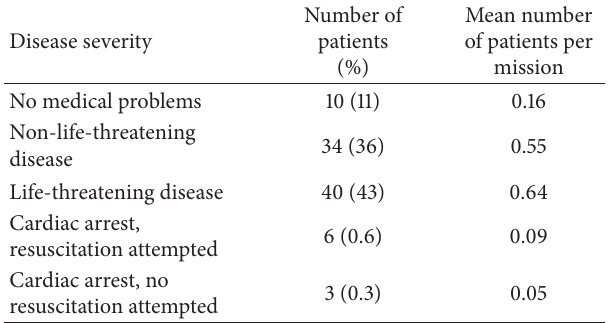
Table 3: Disease severity, by patient and by accomplished mission. Table 4: Reasons for theoretical benefits over counterfactual GEMS facility as judged by the helicopter-based